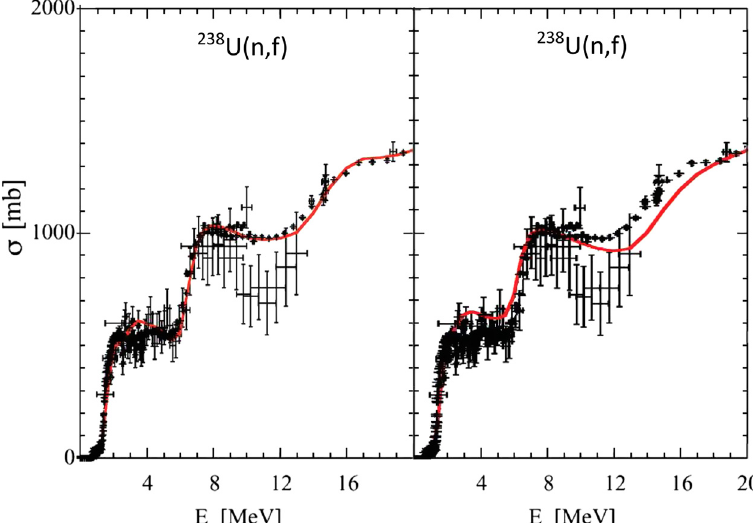
Fig. 12. Neutron induced fi ssion cross-section on 238 U using only fi ssion cross-section as constraint (left panel) or including other relevant channels (right panel) as constraints. The reduced number of parameters gives less freedom to the fi ne tuning and therefore provides with a worse fi t within the coherent approach (see Refs. [42,43] for more